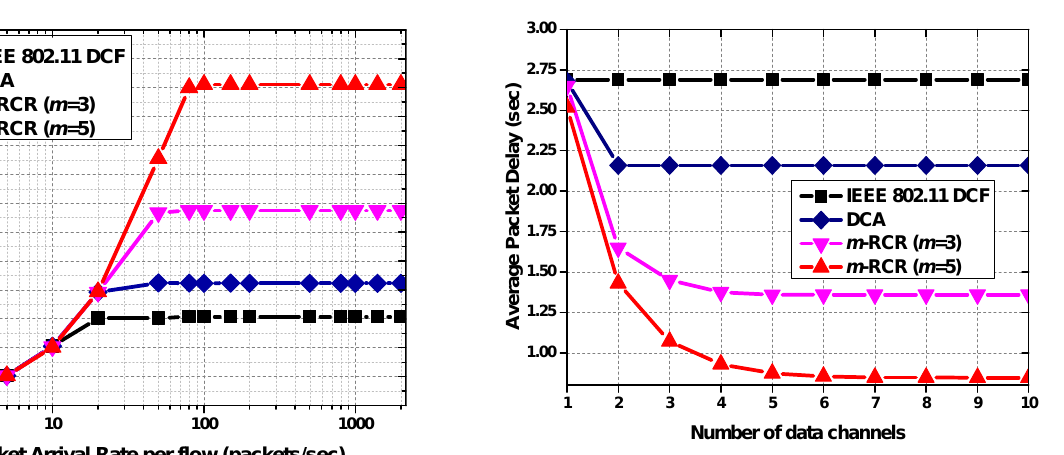
Fig. 3. Aggregate throughput versus packet arrival rate per flow.